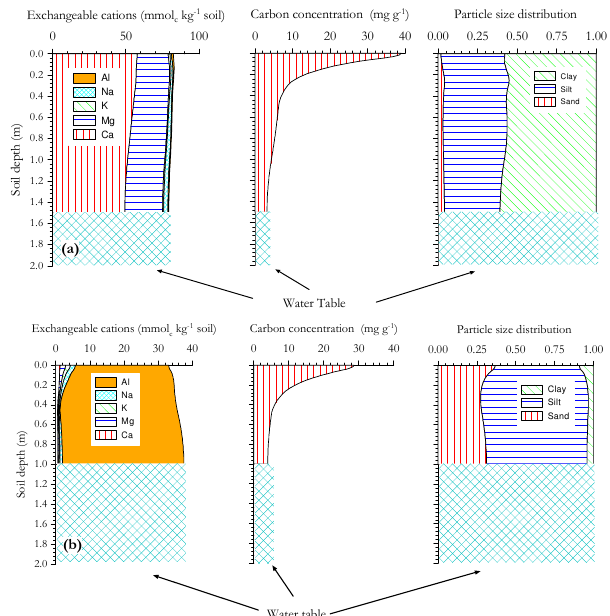
Fig. 16 Fig. 16. Profiles of exchangeable cations, soil carbon and texture for (a) a Haplic Gleysol (Orthoeutric, Siltic) in Ecuador (TIP-03) and (b) for a Haplic Gleysol (Alumic, Hyperdystric) in Colombia